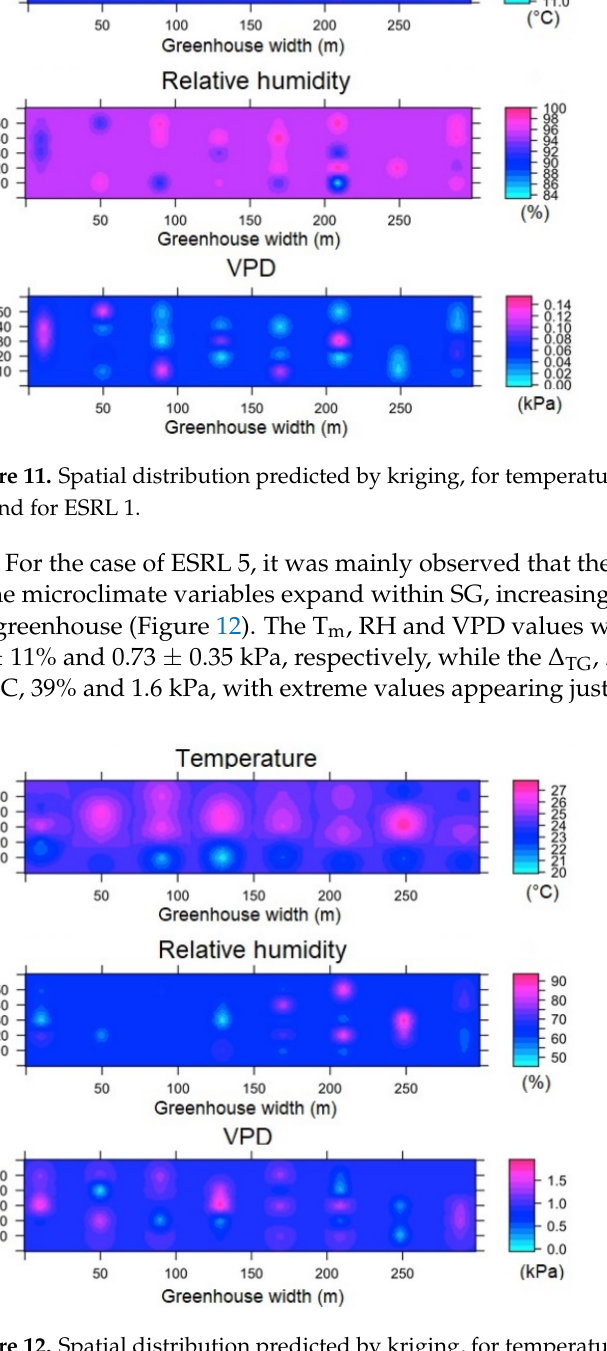
Figure 12. Spatial distribution predicted by kriging, for temperature, relative humidity and VPD in SG and for ESRL 5.